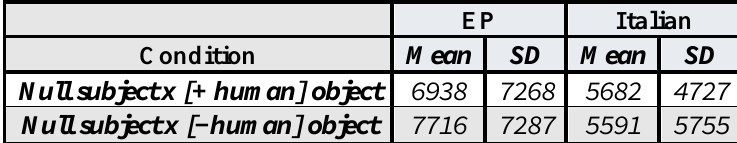
Table 6. Response times (in milliseconds) in the speeded